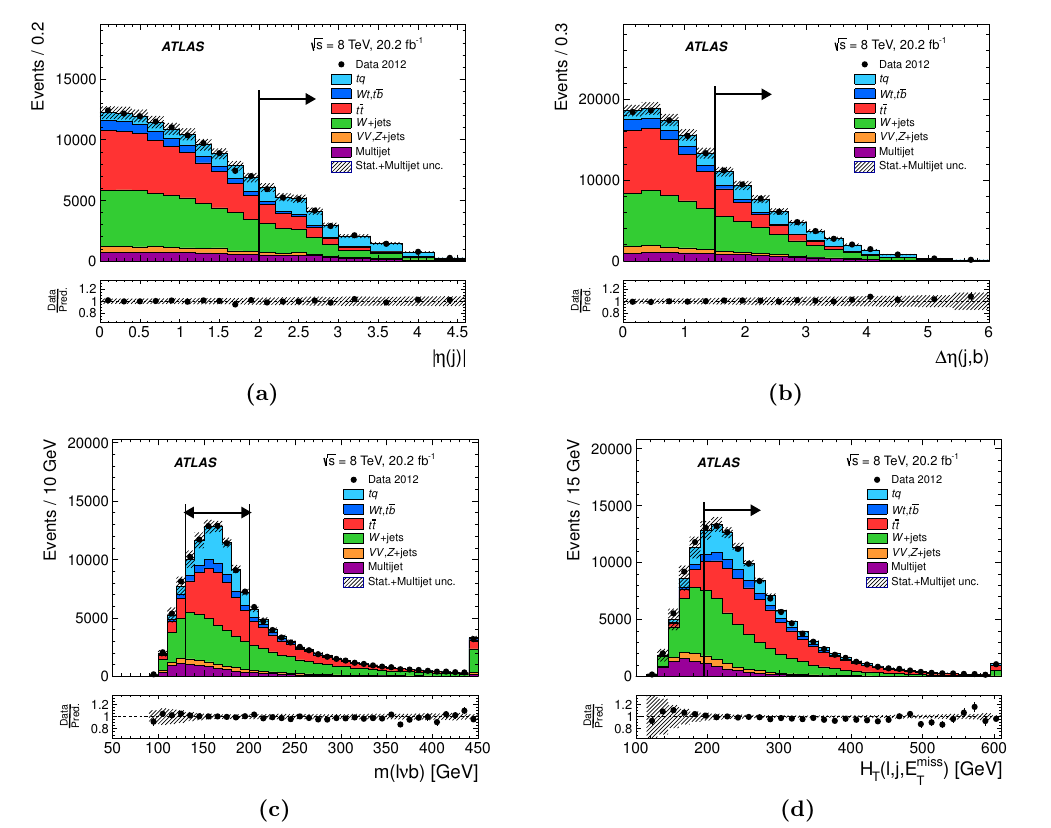
Figure 3. Distributions of the selection variables in the preselected signal region: (a) untagged jet, (b) separation in (cid:17) between the untagged and b -tagged jets, (c) reconstructed top- quark mass, and (d) scalar sum of the p T of the lepton, the p T of the jets and E miss distributions are compared to the predicted signal and background distributions, normalised to the results of the maximum-likelihood (cid:12)t. The labels tq and t (cid:22) b refer to the t -channel and s - channel single-top-quark processes, respectively, and V V to diboson production. The vertical lines and the arrows de(cid:12)ne the signal region. The uncertainty bands include the statistical post-(cid:12)t uncertainty, the uncertainty due to the limited size of the simulation samples and the uncertainty in the normalisation of the multijet background, added in quadrature. The last bin of the histograms includes over(cid:13)ows. The lower panels show the ratio of data to